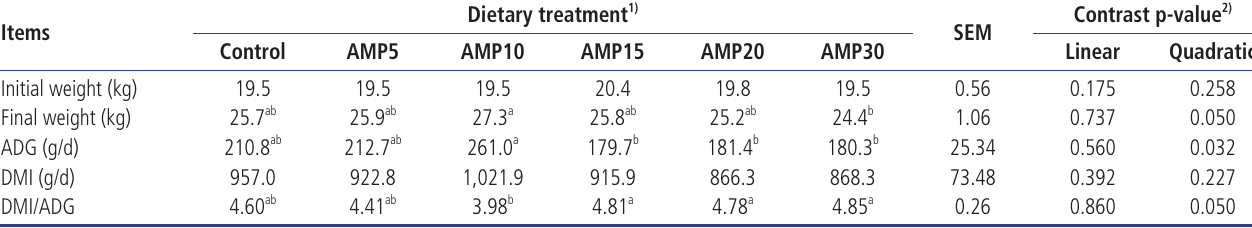
Dietary treatment